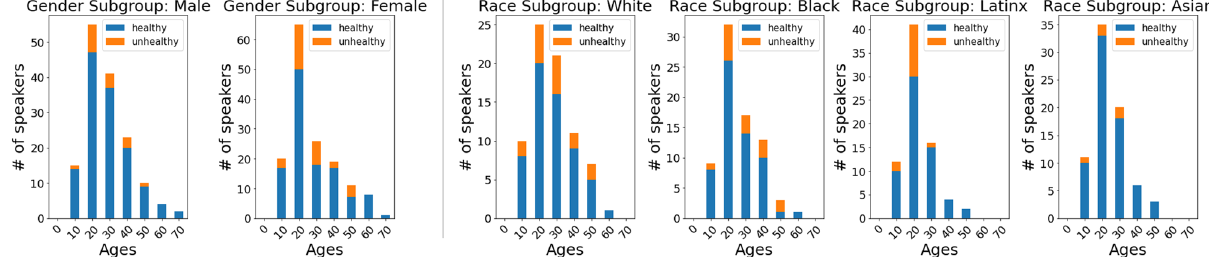
Figure 2. Health condition and age distribution of subgroups. Ages are positively skewed at the age of 20